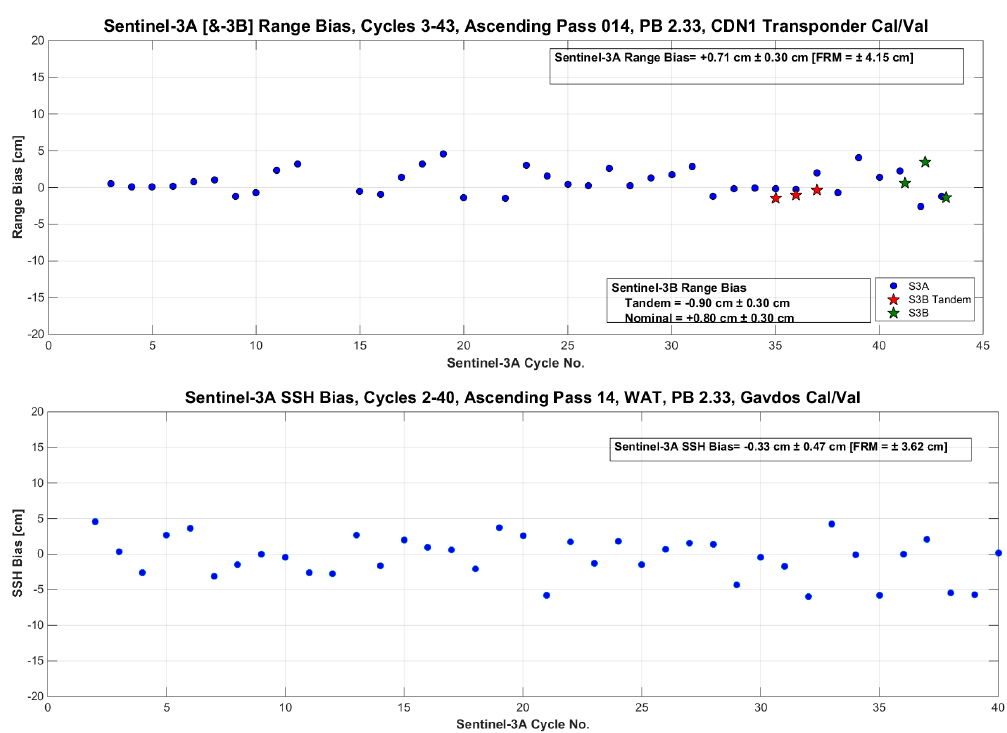
Figure 5. The two diagrams above show the transponder range bias results for Sentinel-3A and Sentinel-3B, and the lower diagram displays the sea-surface calibration results for Sentinel-3A based on the Gavdos and Crete calibration sites. A common practice for altimeter calibration has been to present uncertainties in the form of the standard deviation (i.e., sigma = ± 0.3 cm = ± 3 mm for transponder bias and sigma = ± 0.47 cm = ± 4.7 mm for sea-surface bias uncertainties) based on the sample of Cal/Val biases computed at that point in time. This standard practice is followed in international meetings [13].